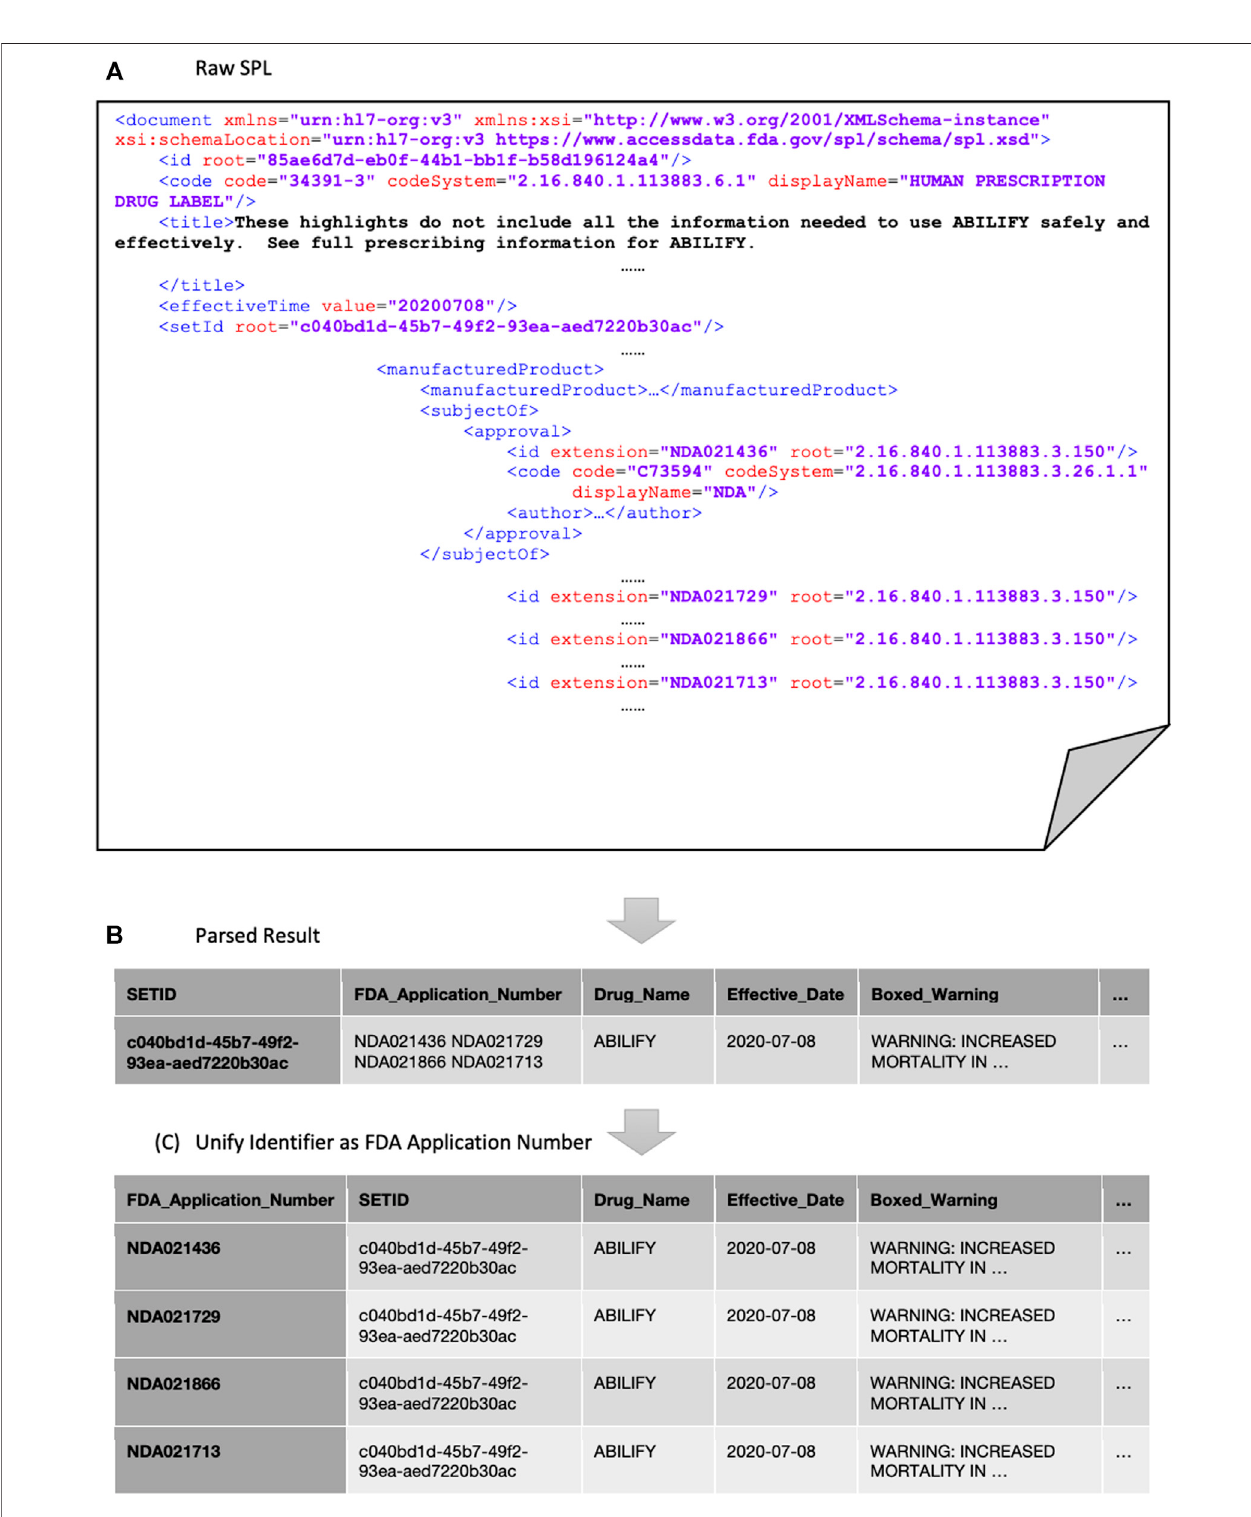
FIGURE 2 | Unify identi fi cation scheme example (DailyMed SETID: c040bd1d-45b7 – 49f2-93ea-aed7220b30ac).